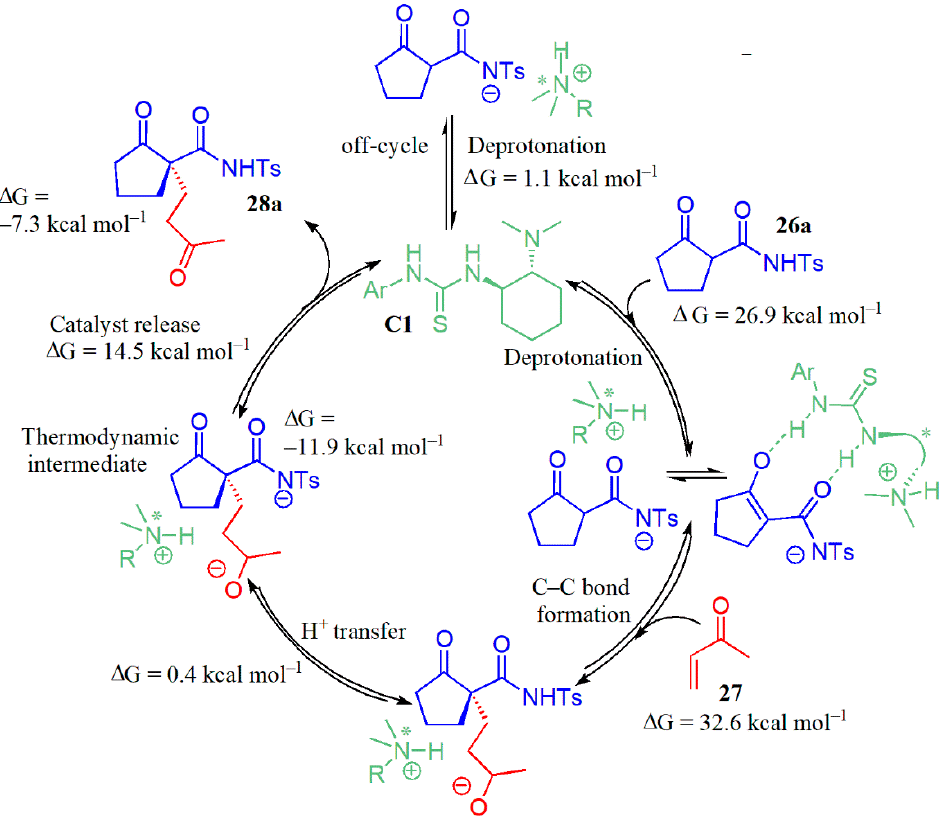
Figure 22. Mechanism postulated for the Michael addition of β -ketoamides to α , β -unsaturated carbonyl compounds, catalyzed by C1 [51].